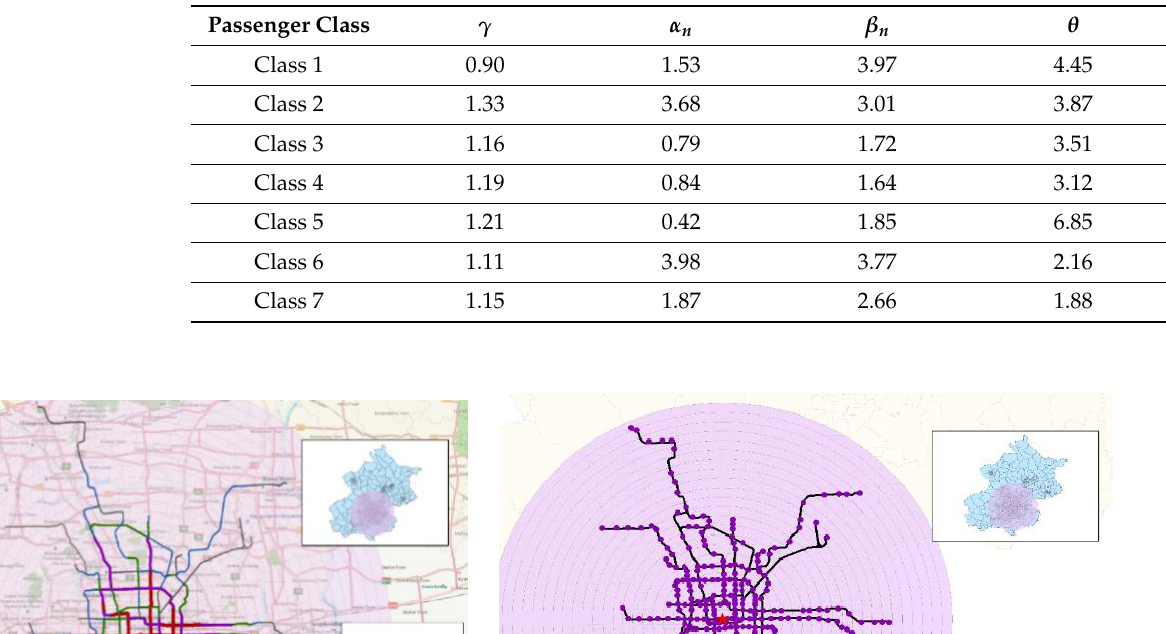
Table 2. Parameter results.